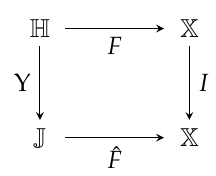
Figure 5. Commutative